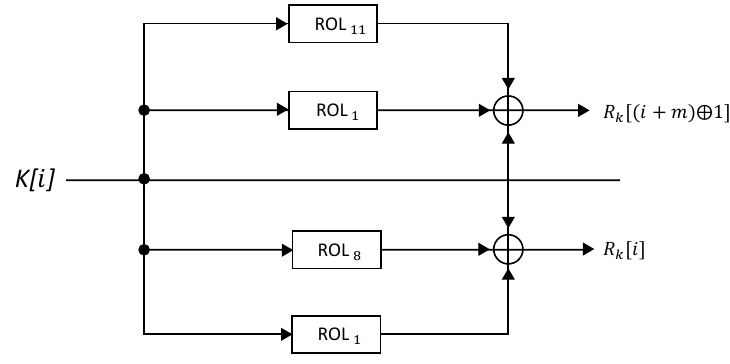
Figure 2. Key schedule of